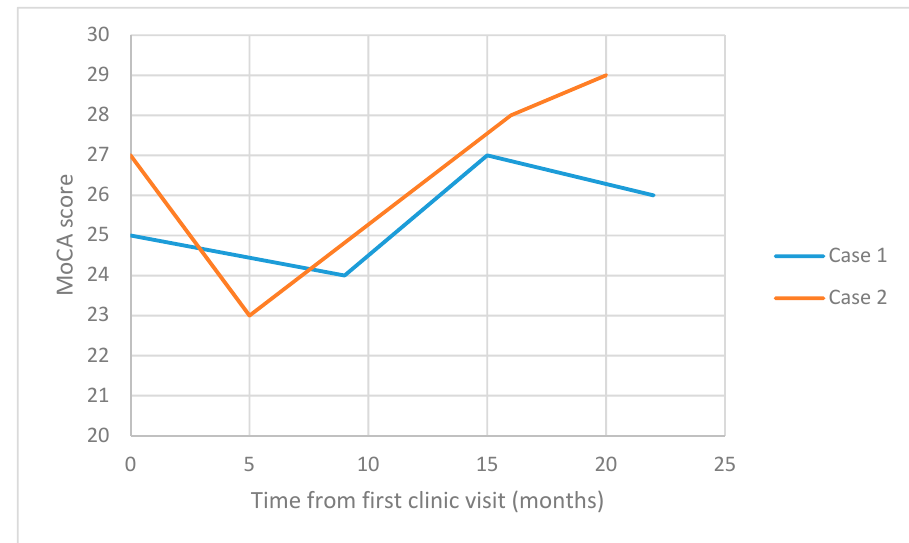
Figure 1. Serial Montreal Cognitive Assessment (MoCA) scores (bonus point included if appropriate) for illustrative cases one and two.